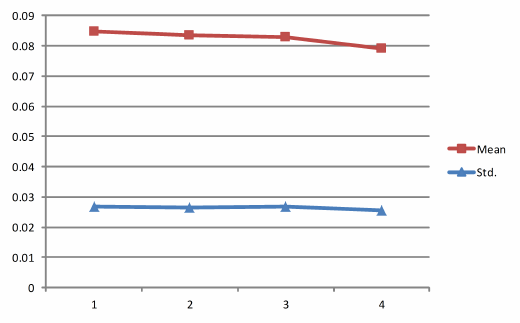
Figure 10: Mean and std.dev. of point based